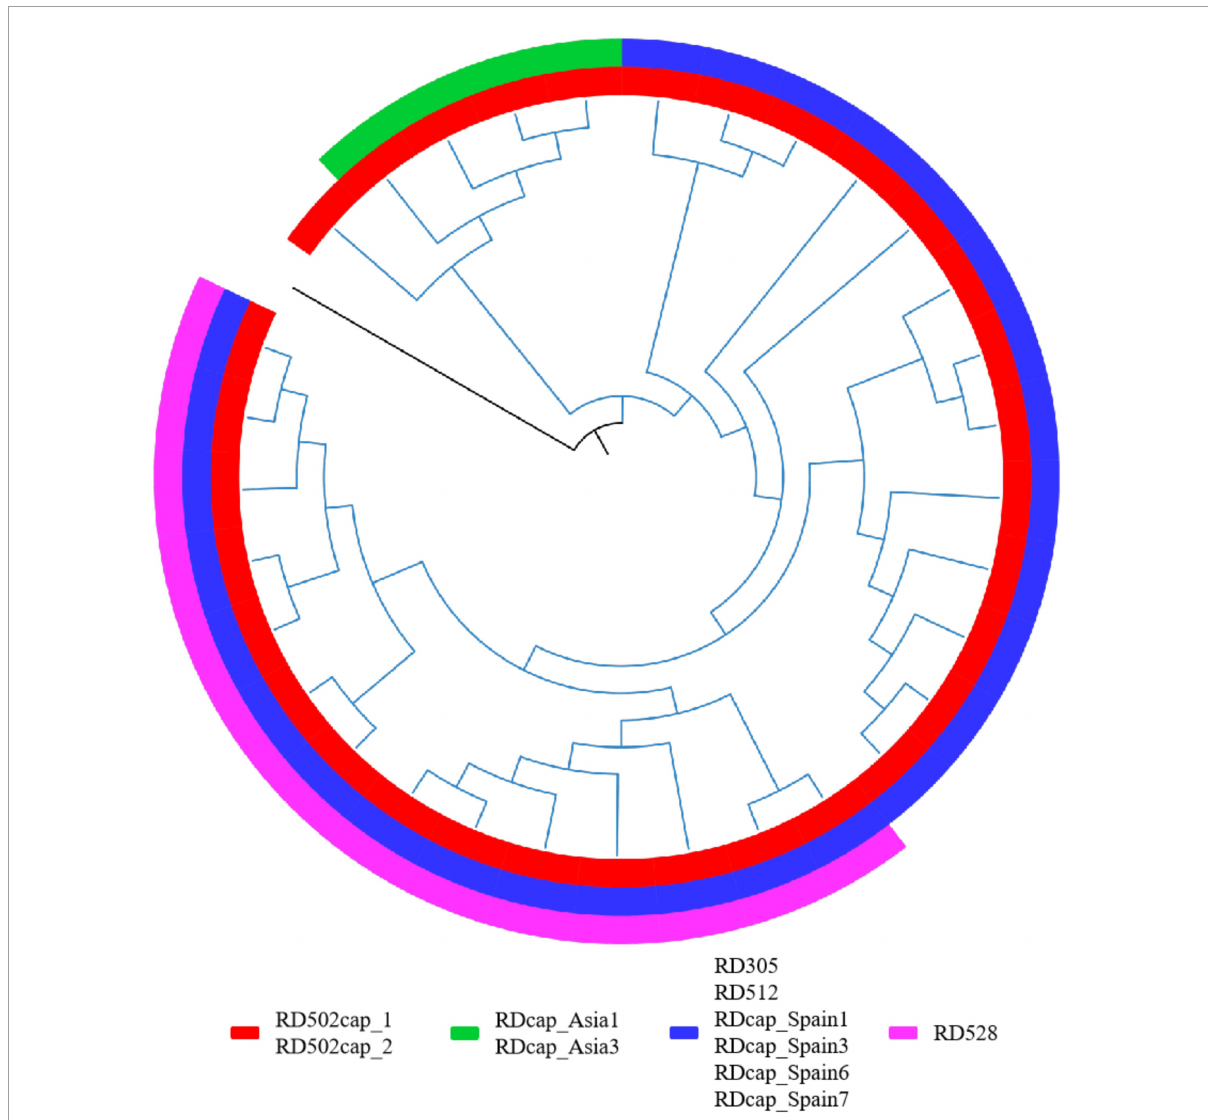
FIGURE6 RDs in M. caprae . The blue branch represents the M. caprae strains and the black is M. canetti as the root. RD502cap_1 and RD502cap_2 are missing in all strains and the remaining RDs are only deleted in partial strains. RD528 is the largest deletion in length (38,328 bp) detected in this study and is deleted in 10 strains within the sampled dataset. Moreover, deletion of RD528 is detected in 4 additional strains out of all M. caprae